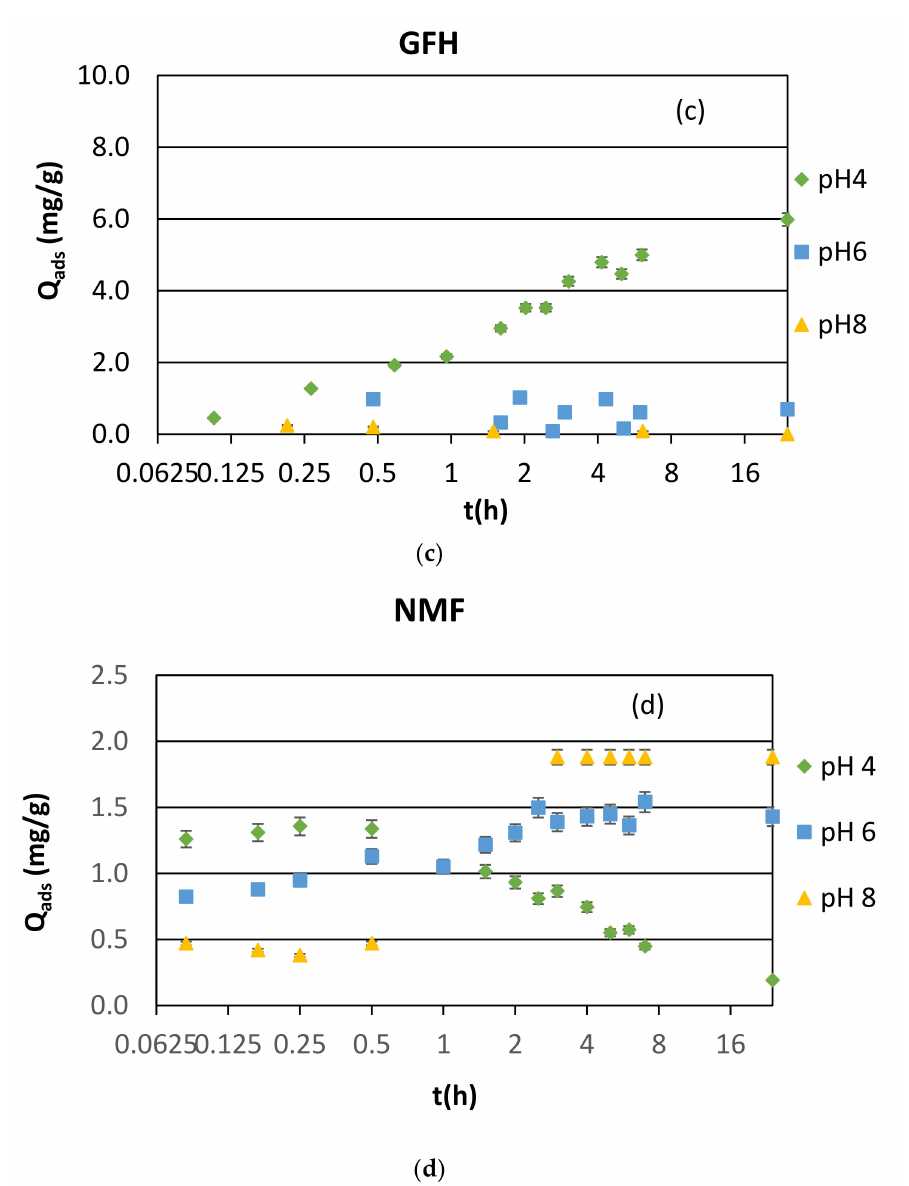
Figure 4. Adsorption capacity at pH = 4, 6, 8 for different initial fluoride concentrations and fixed adsorbent dosage equal to M/V = 1 g/L. ( a ) C 0 = 5 mg/L, GAC, A33E, TiO 2 and GFH; ( b ) C 0 = 2.5 mg/L, A33E, TiO 2 and GFH; ( c ) C 0 = 10 mg/L, A33E, TiO 2 and GFH; ( d ) C 0 = 2.5 mg/L, NMF. The error bars indicate the standard deviation of the analytical